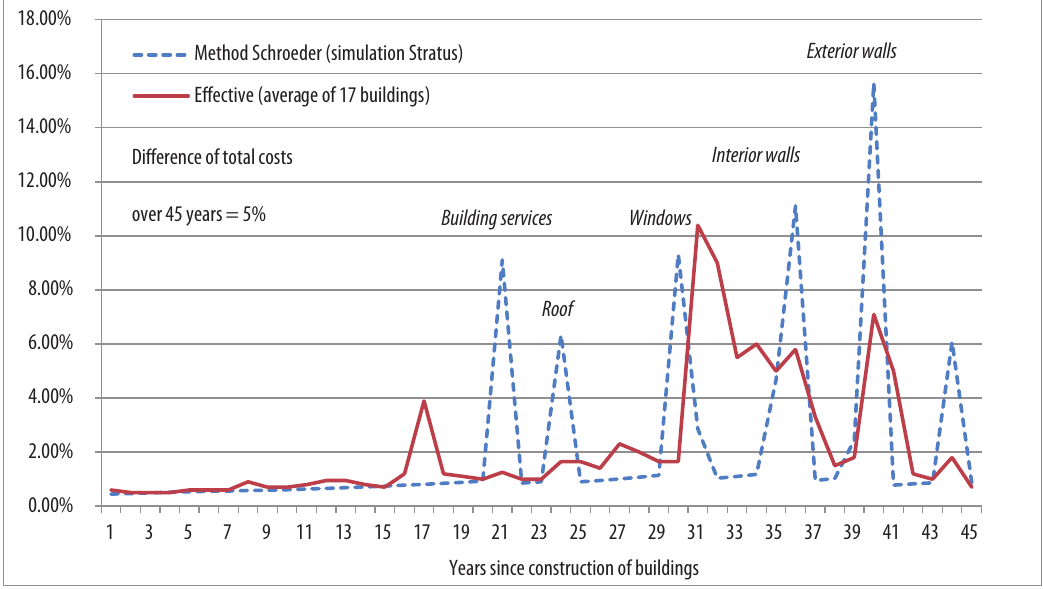
Fig. 6. Comparison of the maintenance and refurbishment costs of 17 buildings analysed in detail by Bahr and Lennerts with a desktop simulation using Stratus/Spectus over a period of 45 years (in Italic: indication of elements causing the distinct peaks in the theoretical